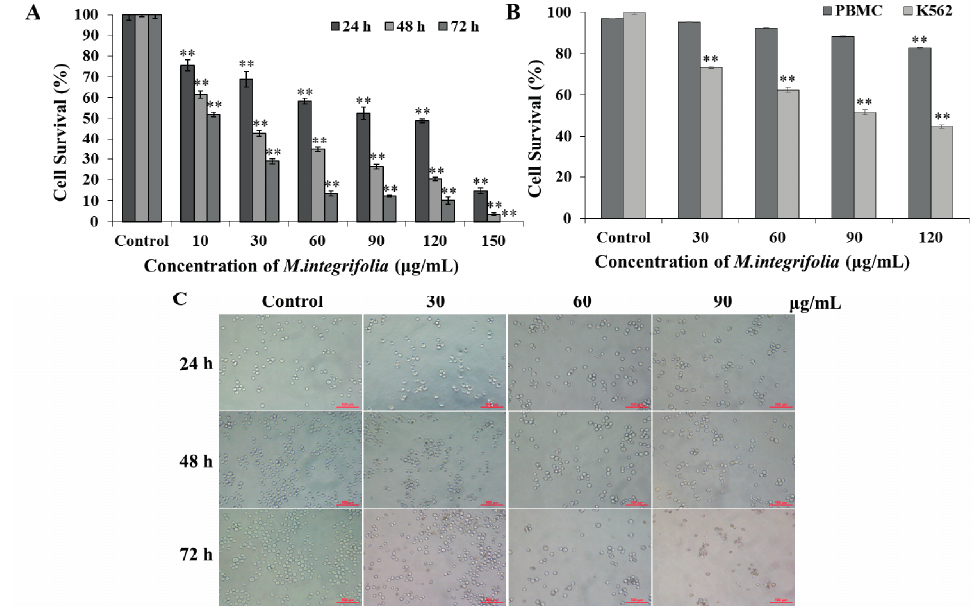
Figure 1. Cell viability tests. ( A ) K562 cells viability after M. integrifolia treatment was measured by MTT assay; ( B ) Cytotoxicity effect of M. integrifolia on PBMCs and K562 cells through Typan blue assay; ( C ) After treatment with different concentrations